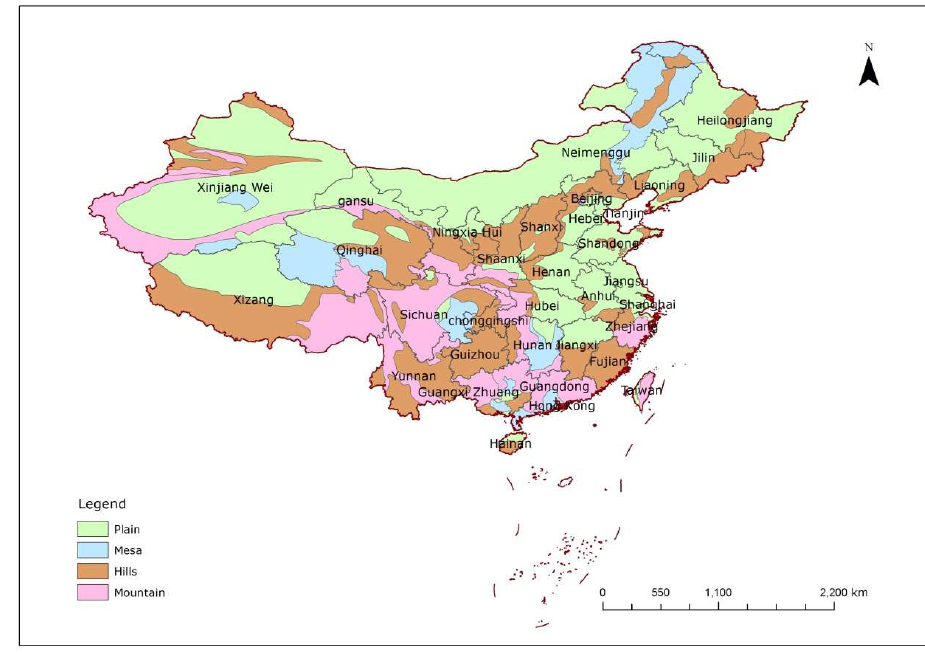
Figure 5. National geomorphic regionalization map.